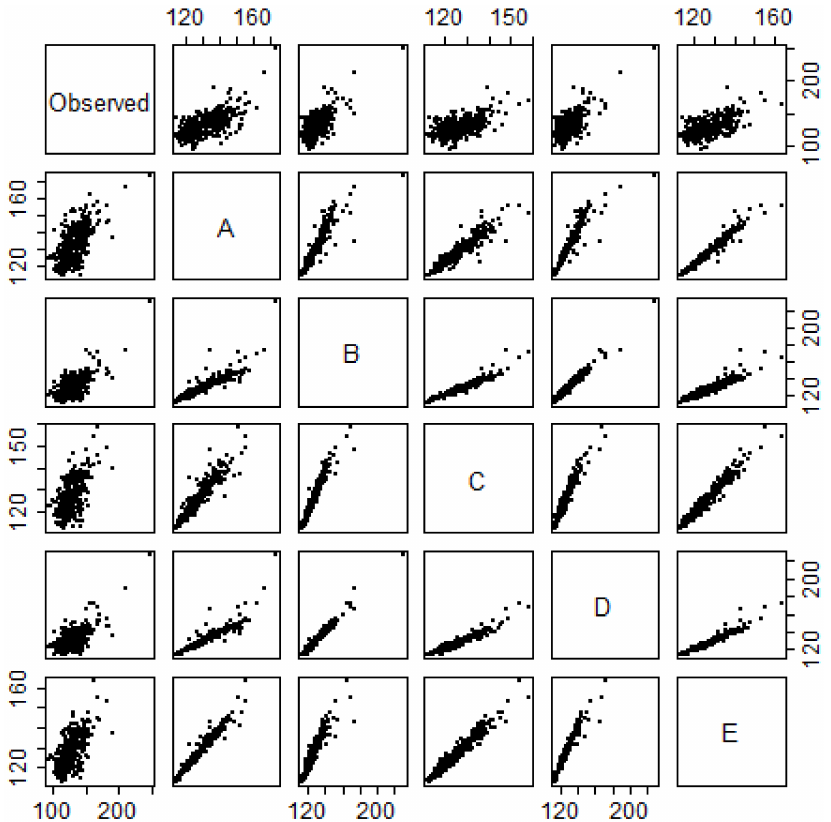
Fig 3. Scatterplot of observed non-external cause mortality and predicted counts from models where HI > = 90˚F. (A) temporal and weather-adjusted model; (B) heat-relatedEMS calls, temporal-adjustedmodel; (C) heat-related ED visits, temporal-adjustedmodel; (D) heat related EMS calls, temporaland weather- adjustedmodel; (E) heat-relatedED visits, temporal and